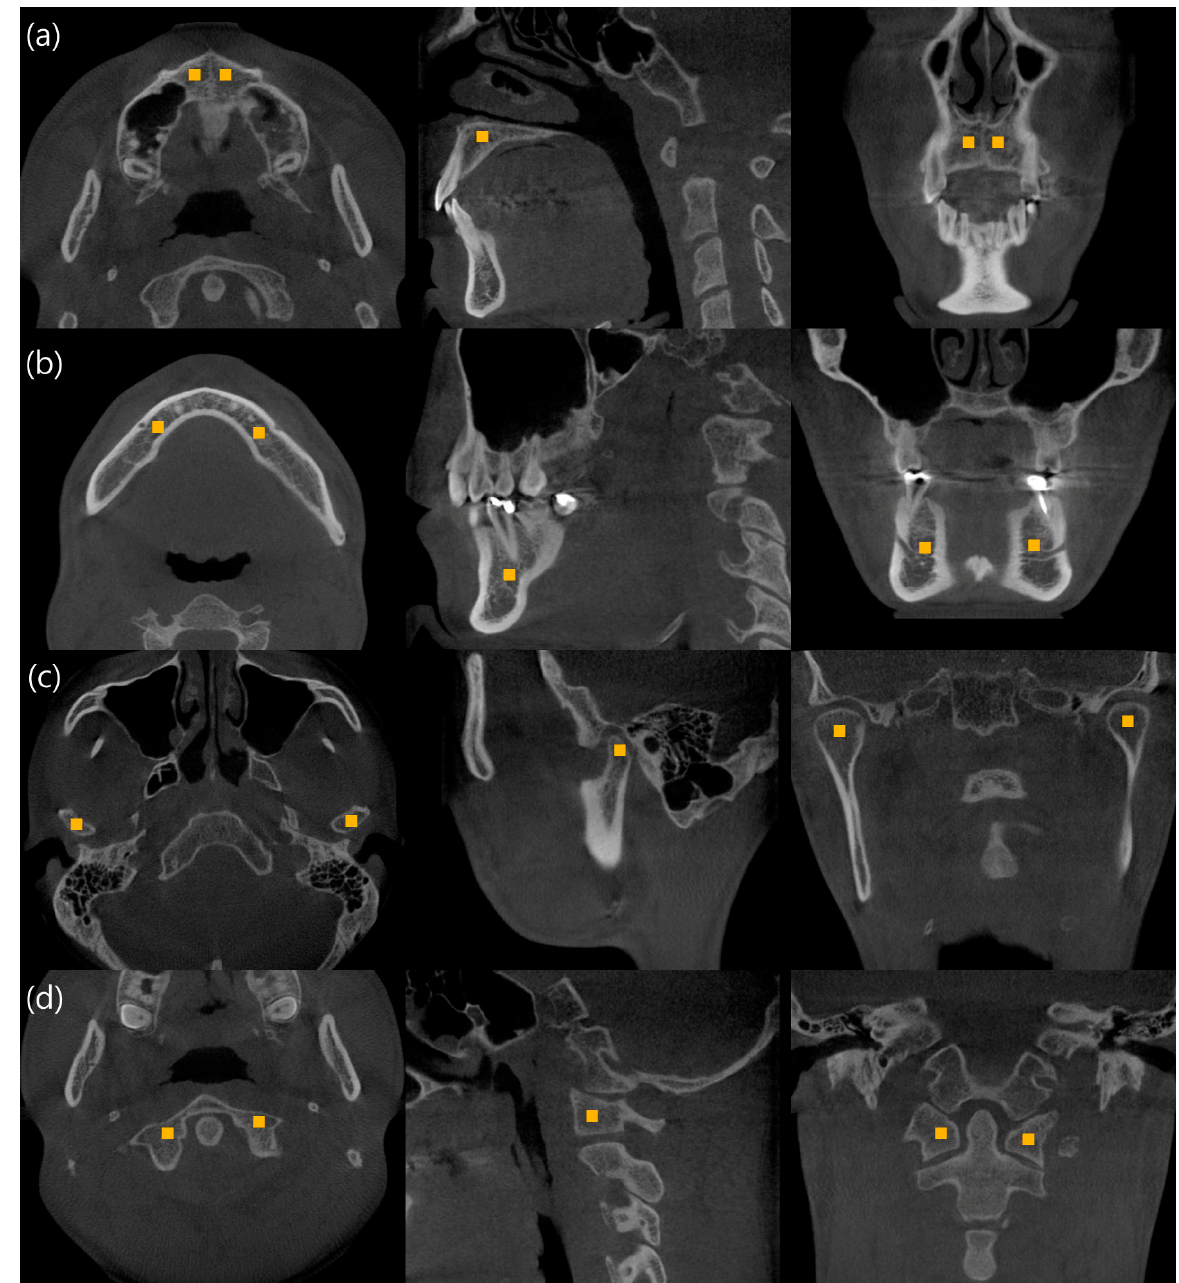
Figure 1. Regions of trabecular bone density measurement (yellow square points): ( a ) Anterior basal bone beside the incisive foramen in maxilla (Mx); ( b ) body of mandible, medial side of mental foramen (Mn); ( c ) condyles of mandible, center of medial, and lateral pole (Co); ( d ) lateral mass of the first cervical vertebra (Cv). The Invivo5 (Anatomage, San Jose, CA, USA) software was used for the Hounsfield unit measurement, and the CTan (Bruker micro-CT, Kontich, Belgium) software was used for the trabecular microstructure analysis (Figure 2).